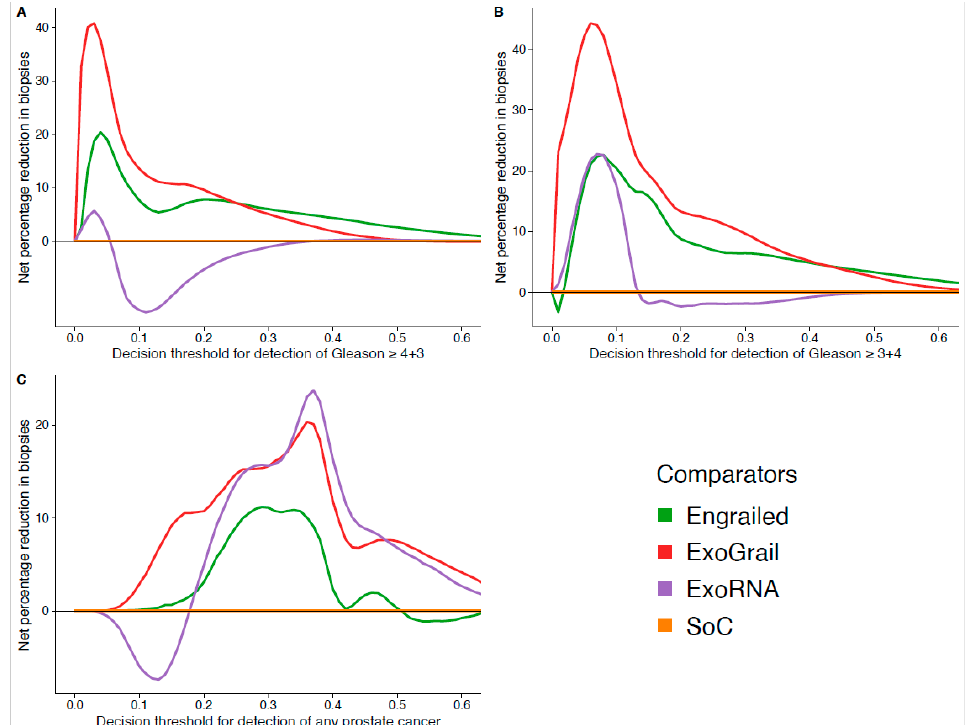
Figure 6. Estimation of biopsy reduction, as calculated by comparing the DCA-calculated net benefit of each risk model to the net benefit of the standard of care (SoC) model. The accepted patient/clinician risk threshold for accepting biopsy is detailed on the x-axis. Different biopsy outcomes are shown in each of the three panels: ( A ) detection of Gleason ≥ 4 + 3, ( B ) detection of Gleason ≥ 3 + 4 and ( C ) any cancer. Coloured lines show differing comparator models; Orange—biopsy patients according to the SoC model, Green—biopsy patients based on the Engrailed model, Purple—biopsy patients based on the ExoRNA model, Red—biopsy patients based on the ExoGrail model. To assess the benefit of adopting these risk models in a clinically relevant population we used data available from the control arm of the CAP study [42] for proportionally resampling the ExoGrail cohort. DCA curves were calculated from 1000 bootstrap resamples of the available data to match the distribution of disease reported in the CAP trial population. Net benefit averaged over all resamples was used to calculate the potential reductions in biopsy rates here. See Methods for full details.